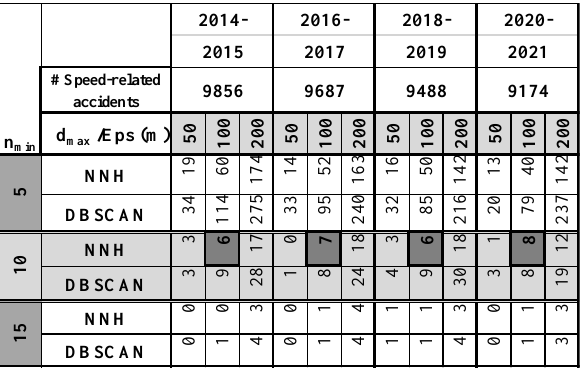
Table 2. Clustering results using NNH and DBSCAN with various n min ( 5/10/15 accidents) and d threshold (50m, 100m, 200m)